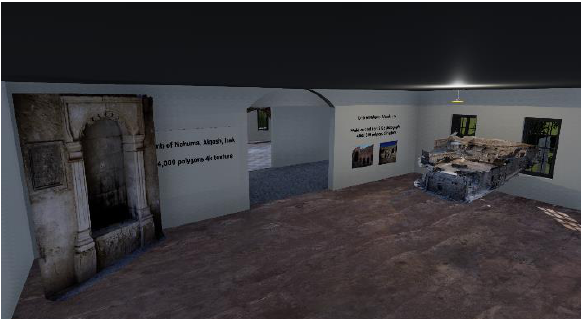
Figure 13. Texture detail – inside